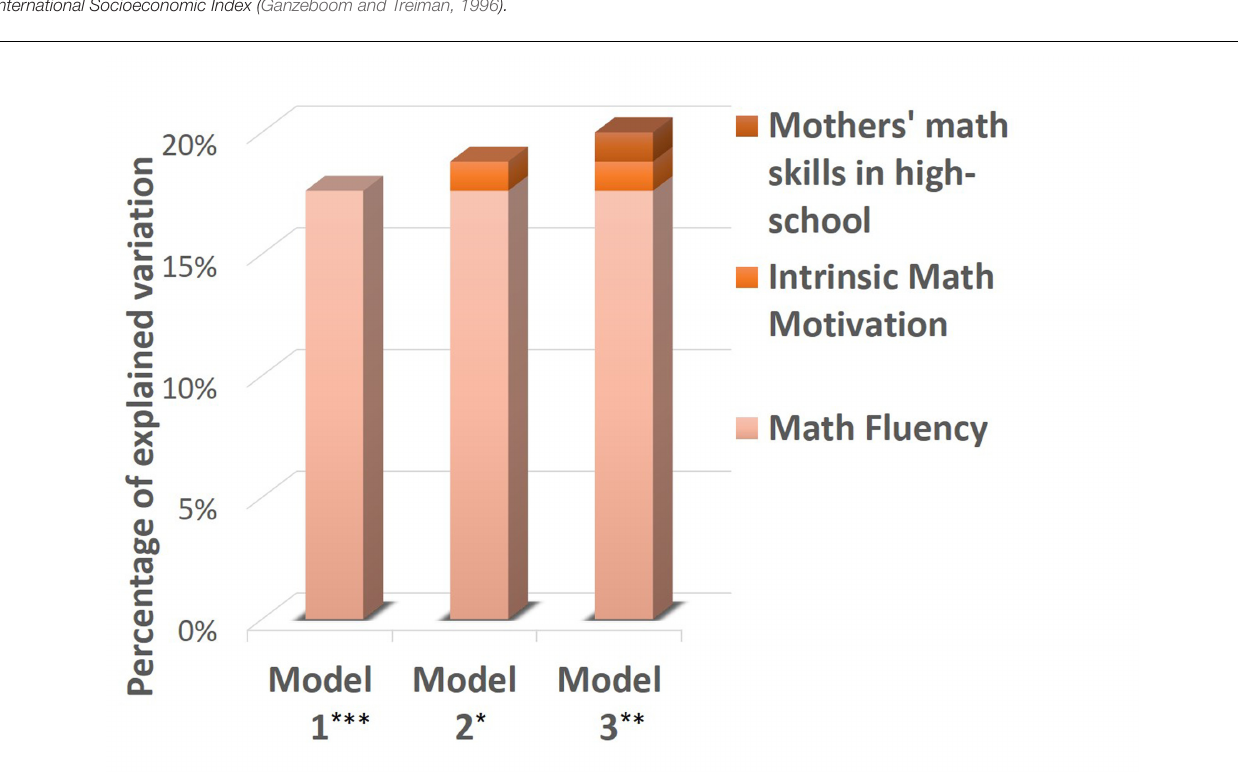
FIGURE 6 | A schematic summary of the hierarchical regression analyses to predict children’s explicitly measured math anxiety (i.e., by the AMAS self-report questionnaire). ∗ p = 0.08, ∗∗ p = 0.05, ∗∗∗ p <